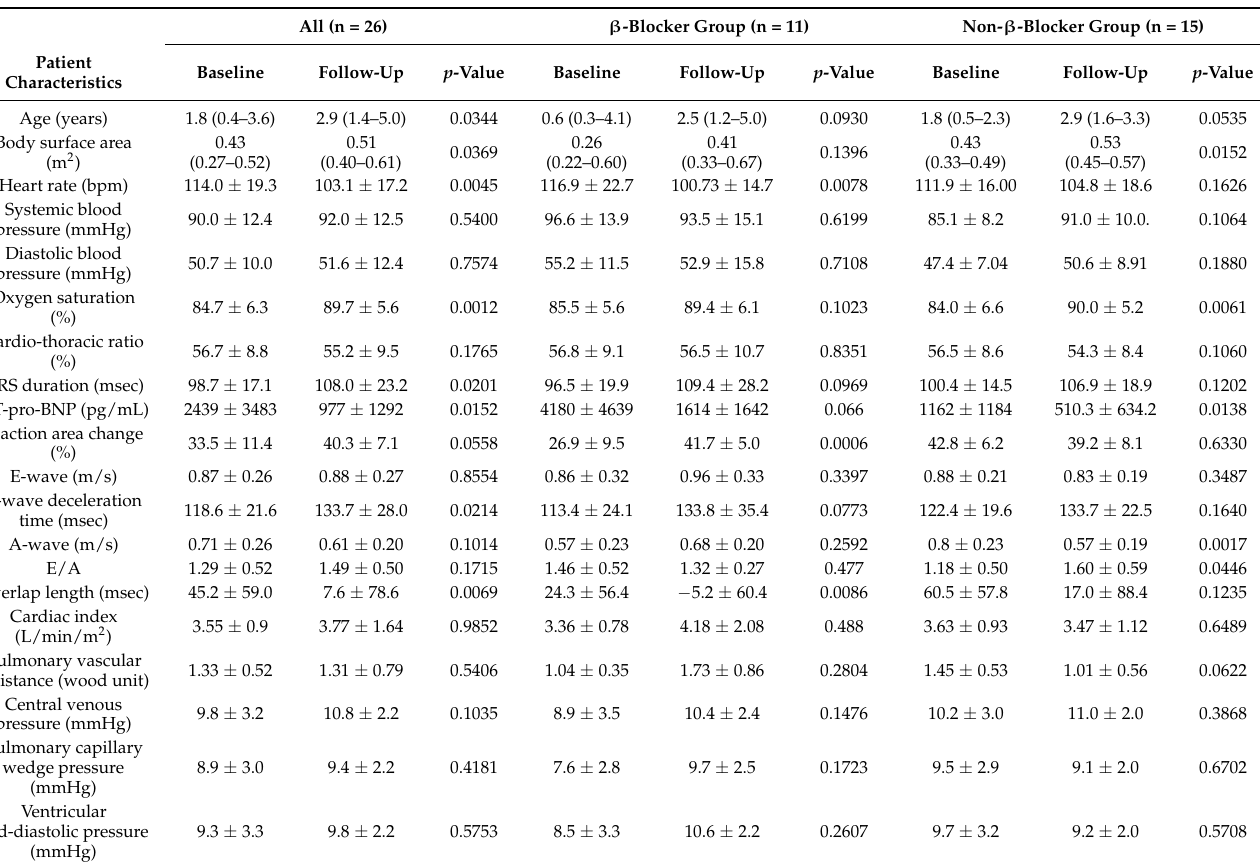
Table 2. Comparison between baseline and follow-up